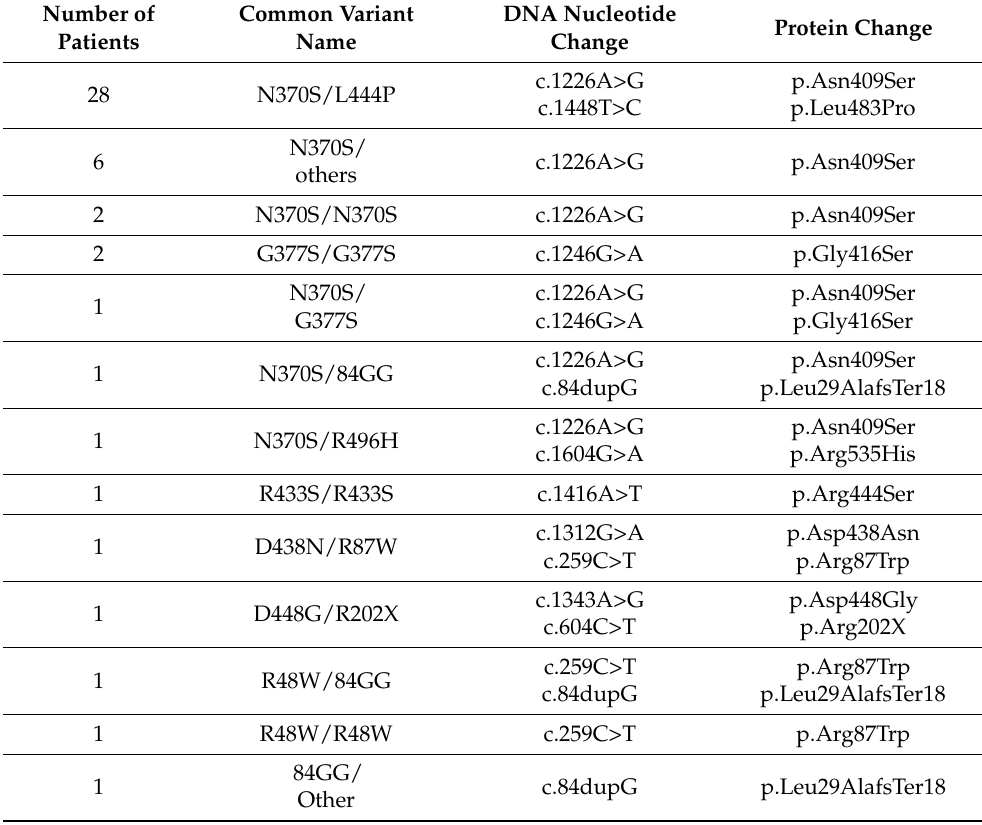
Table 1. GBA1 pathogenic variants in GD1 patients. Number of